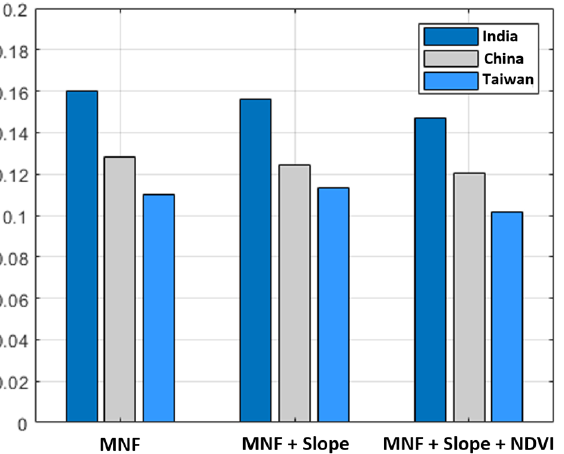
Figure 6. The final reconstruction loss of the proposed CAEs for different input features in all study areas.